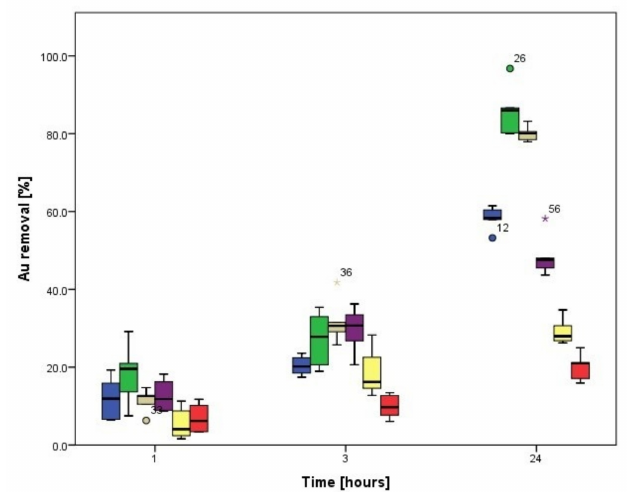
Figure 8. Au removal by 0.050 g (wet weight) of Cladosporium cladosporioides pellets at different pH values and contact times. pH: (cid:4) : 2; (cid:4) : 3; (cid:4) : 4; (cid:4) : 5; (cid:4) : 6; (cid:4) : 7.